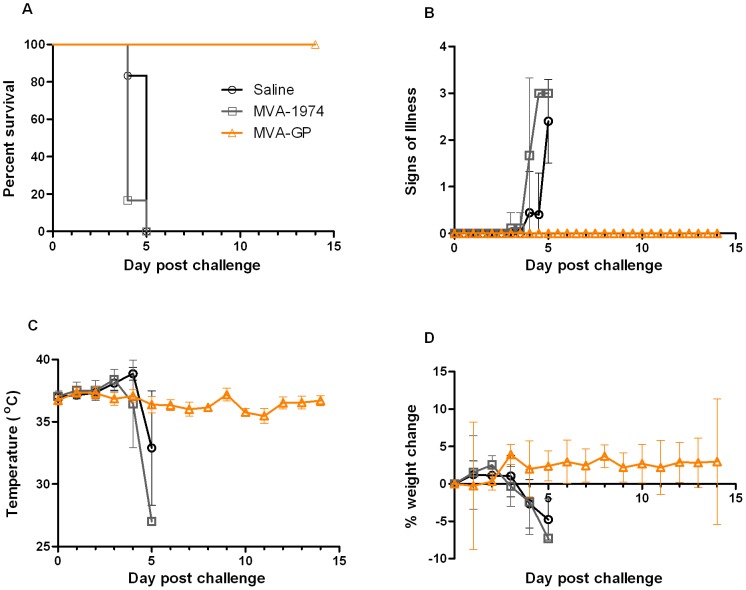
Efficacy of MVA-GP in A129 mice challenged with CCHFv.A129 mice (n = 6) were challenged with double the minimum lethal dose of CCHFv 14 days after booster vaccination with MVA-GP (orange triangles), MVA 1974 (grey squares) or saline (black circles) and monitored for the following 14 days. All mice vaccinated with MVA-GP survived lethal challenge, and did not show any signs of illness, become febrile, or exhibit weight loss. (A) Percentage of surviving animals. (B) Signs of illness. Mean ± standard deviation is plotted. (C) Body temperature. Mean ± standard deviation is plotted. (D) Weight change as a percentage of body weight at challenge. Mean ± standard deviation is plotted.